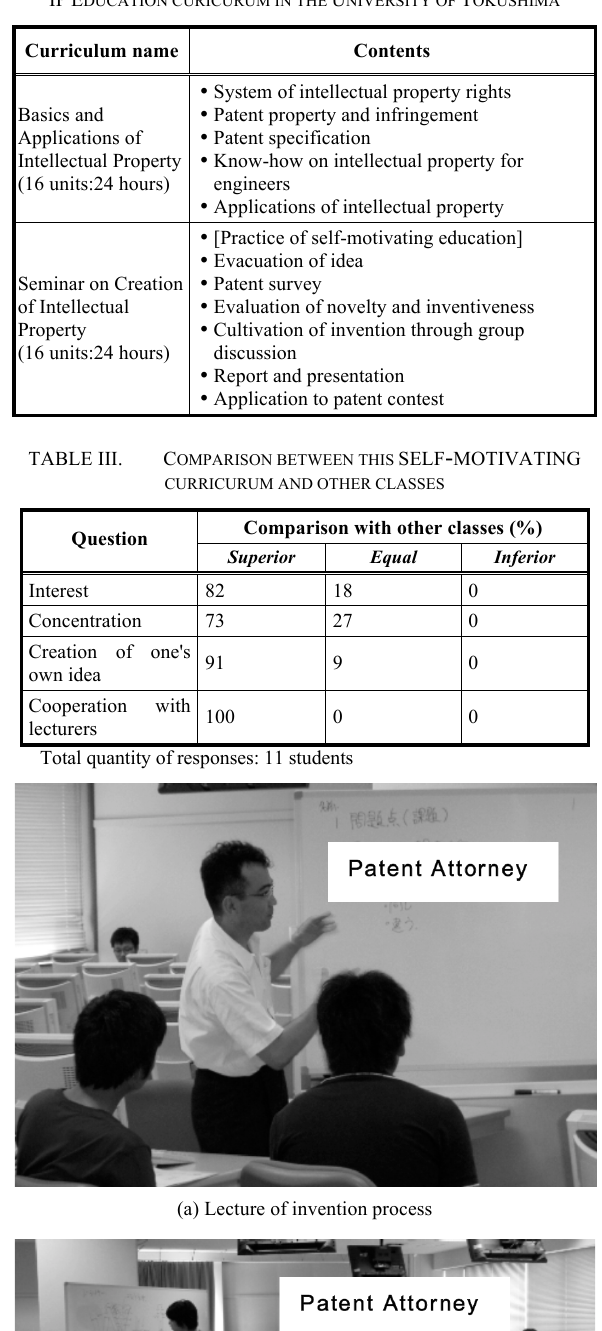
TABLE II. IP E DUCATION CURICURUM IN THE U NIVERSITY OF T OKUSHIMA